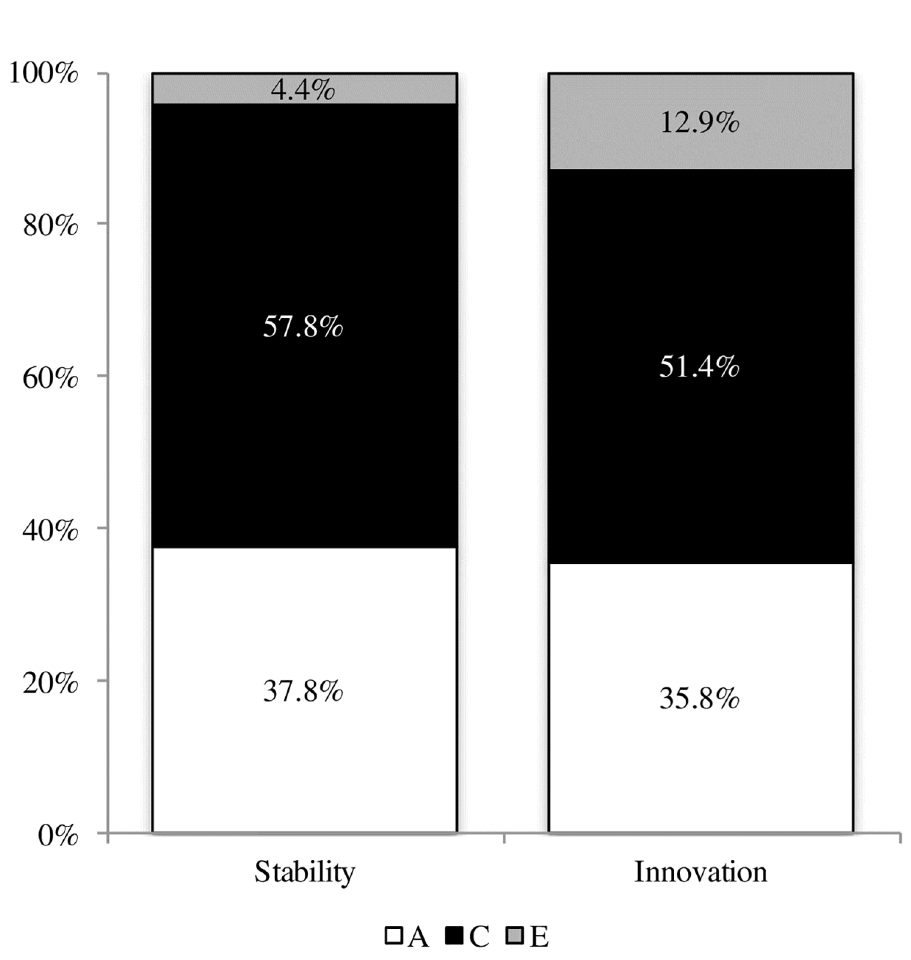
Fig 2. Standardized varianceestimatesof genetic, shared and nonshared environment latent factors associated with stability of negative emotionality from 5 to 18 months of age and to total innovation effects.